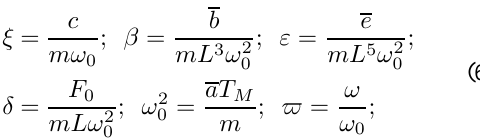
Fig. 5. Evolution of phase spaces due to variation of the force amplitude parameter δ . (a) δ = 0 . 05875 , period-2; (b) δ = 0 . 059 , period-4; (c) δ = 0 . 0592 , period-8; (d) δ = 0 . 0593 , chaos; (e) δ = 0 . 0595 , chaos; (f) δ = 0 . 05965 , chaos; (g) δ = 0 . 059675 , chaos; (h) δ = 0 . 05969 , chaos; (i) δ = 0 . 06 ,